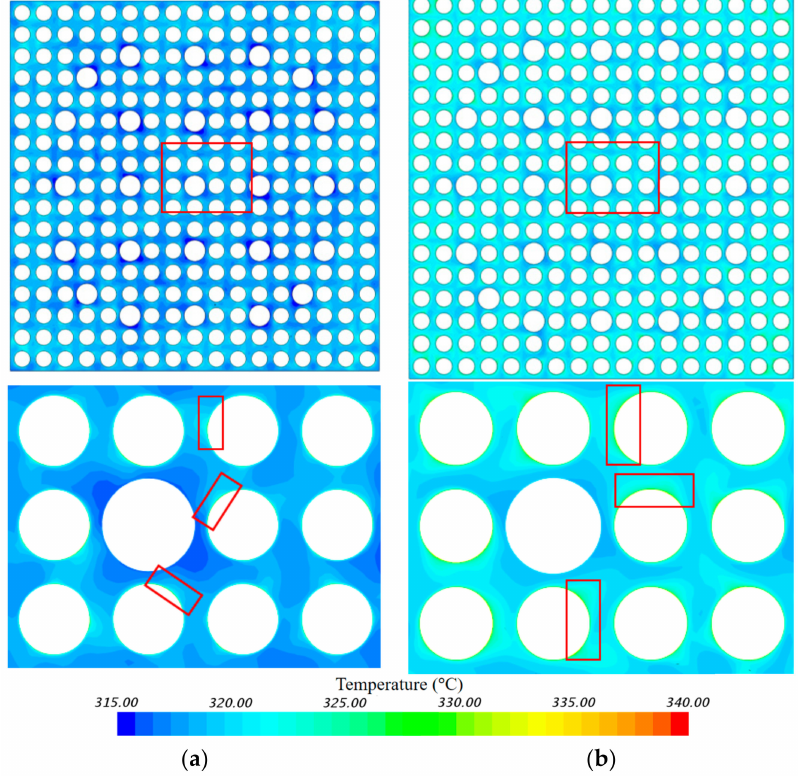
Figure 19. Temperature field in the plane downstream of the third mixing grid: ( a ) 5 mm downstream of the grid and ( b ) 400 mm downstream of the